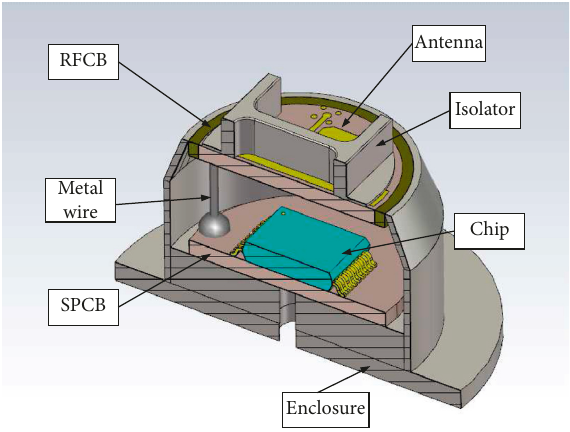
Figure 8: The structure of the field model.